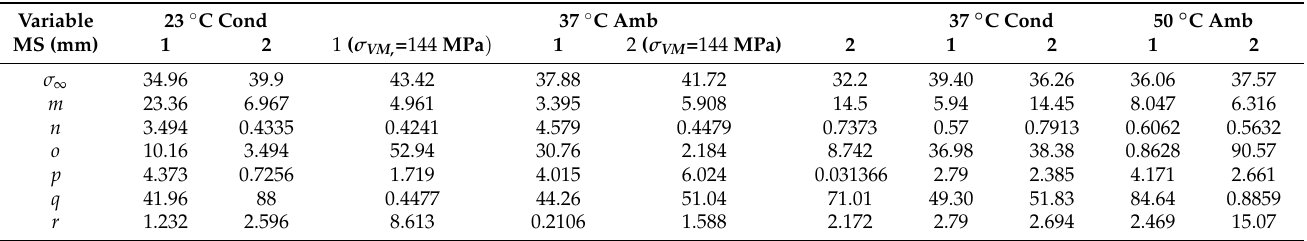
( c ) Figure 8. Comparison of the experimental data to the simulation of Group II for two mesh sizes (MS = 1 mm and MS = 2 mm). HC = 1 mm: HC identified with MS = 1 mm, HC = 2 mm: HC identified with MS = 2 mm. The shaded area indicates a ±10% force region around the experimental curve. ( a ) Experimental and simulated force–displacement curves at 37 °C (conditioned) with the extended Hockett–Sherby model including the resulting 𝑅 (cid:2870) . ( b ) Experimental and simulated force–